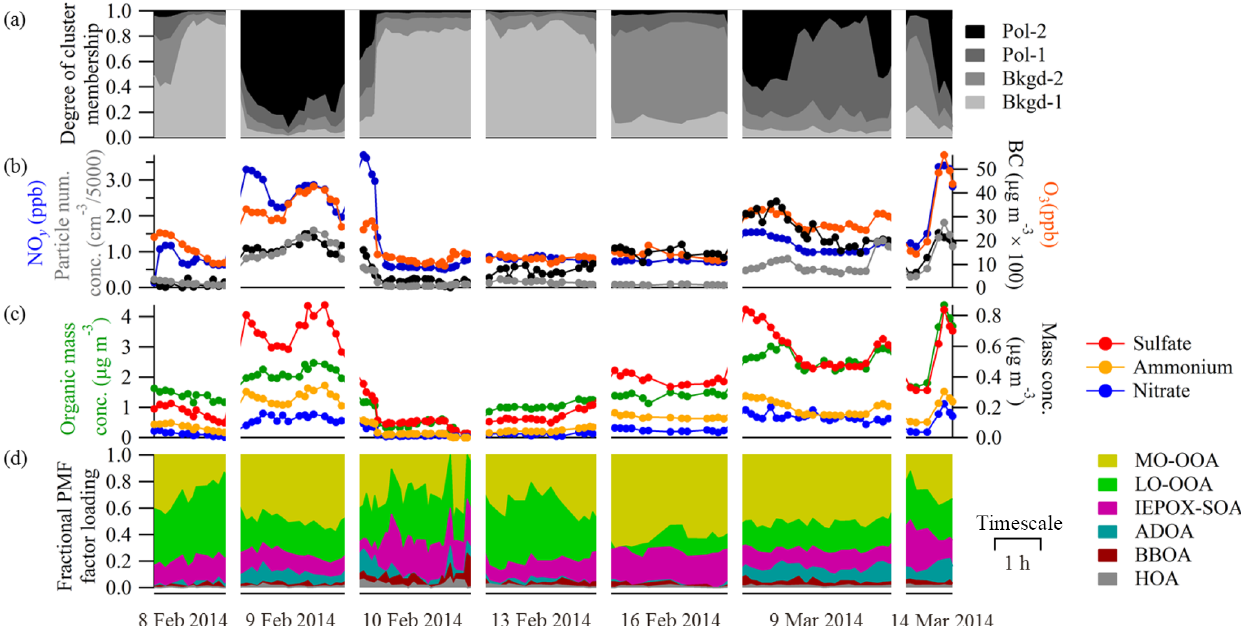
Figure 6. Results of the cluster analysis by fuzzy c-means (FCM) for afternoon periods (12:00 to 16:00LT) are presented by several case studies. (a) The degree of membership in each of the four clusters. The sum of the degrees of membership across all clusters is unity. Background conditions are abbreviated as “Bkgd”, and polluted conditions are abbreviated as “Pol”. (b) Pollution indicators: concentrations of NO y , O 3 , black carbon (BC), and particle number count are plotted. (c) PM 1 mass concentrations for organic, sulfate, nitrate, and ammonium species. (d) Fractional contribution of each factor to total organic PM 1